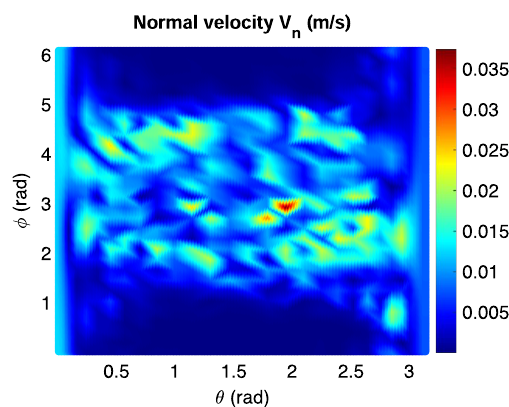
Figure 8. Sketch of the geometry in sensitivity analysis. D 1 , D 2 and x 1 , x 2 are original near controls and far fi eld directions, respectively. They are shown in dark color. The light-colored regions with D (cid:7) n , where n = 2, 3 and 4, are corresponding to the 1 experiments in Sections 3.3.2 to 3.3.4.